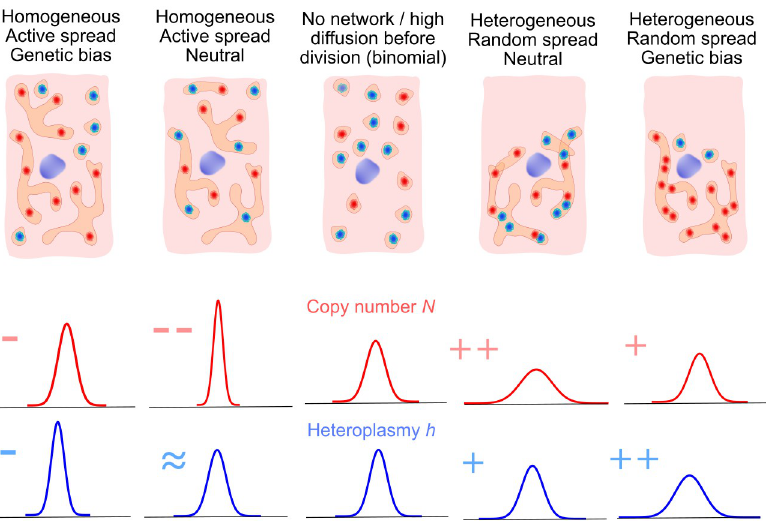
Fig 6. Illustration of the range of influences of network structure and contents on mtDNA statistics from partitioning. MtDNA molecules distributed randomly through the cytoplasm are segregated binomially (centre); the influence of network structure (heterogeneous or homogeneous distributions) and mtDNA inclusion (genetically neutral or biased) changes cell-to-cell variability in different ways: Depending upon genetic bias and network heterogeneity, networks can both increase and decrease cell-to-cell mtDNA variability in copy number and heteroplasmy. Genetic bias for network inclusion can modulate (physical) copy number statistics, by influencing the total number of mtDNA molecules that are evenly spread through the